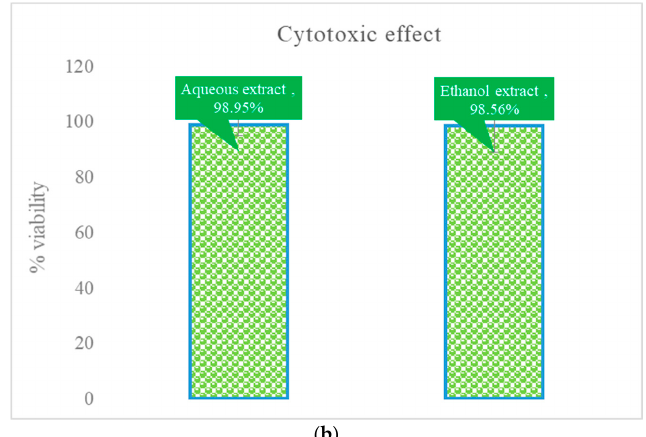
Figure 1. ( a ) Emetine standard @ IC 50 – 0.020 µM; ( b ) % viability of HeLa cells with water and ethanol extracts.